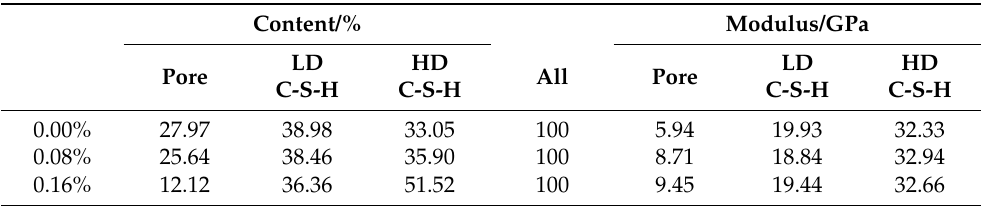
Table 3. The micromechanical properties of cementitious